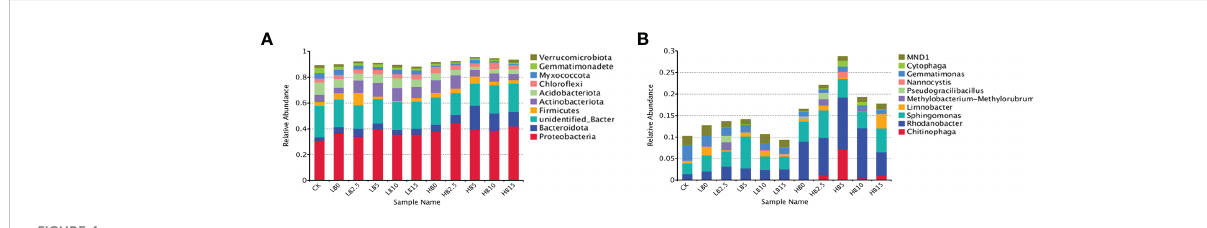
FIGURE 4 Relative abundance of bacterial community structure in different treatments. (A) Phylum level and (B) genus